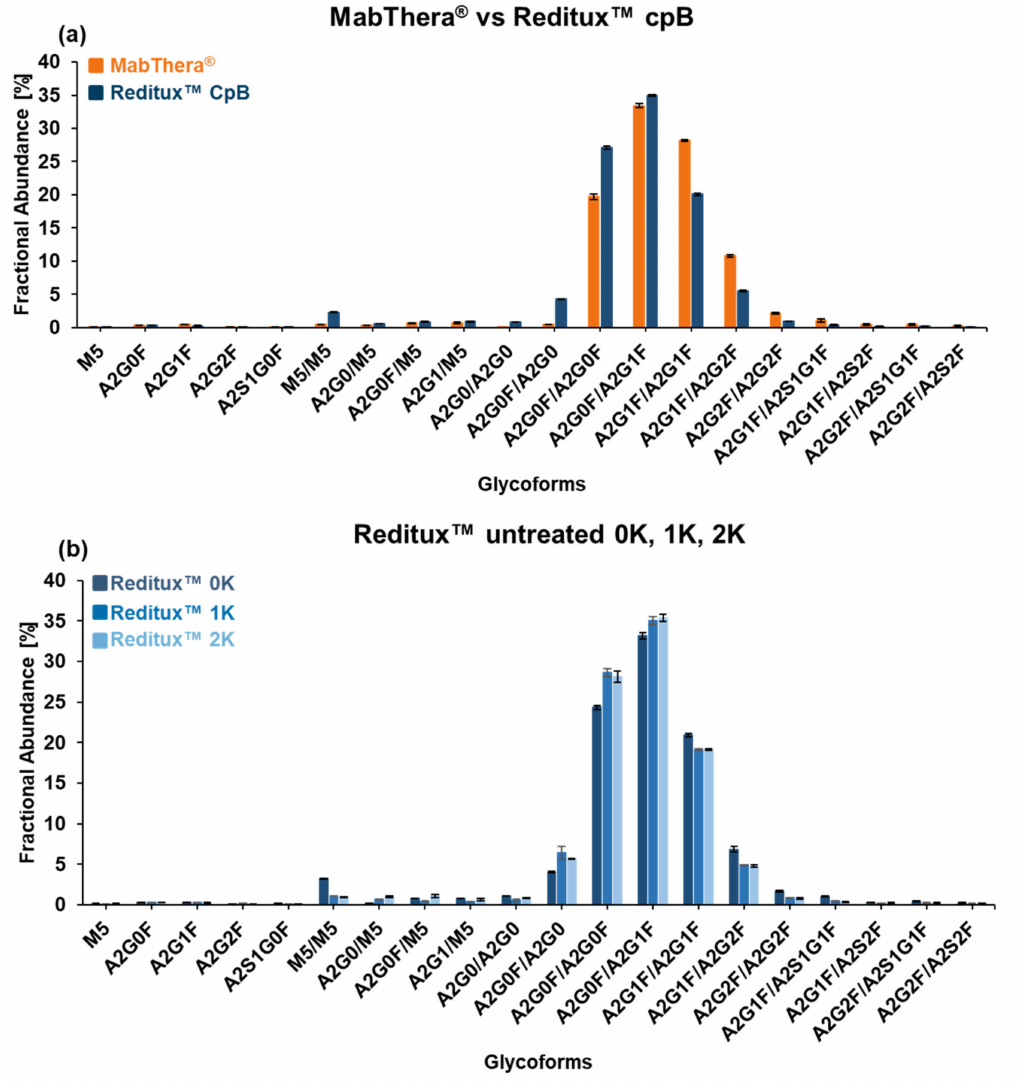
Figure 5. Glycoform fractional abundance was obtained by area integration of extracted ion current chromatograms (EICCs). Bar charts of glycoform fractional abundance of ( a ) MabThera ® and Reditux™ after carboxypeptidase B (CpB) tretament, ( b ) Reditux™ different lysine variants (0K, 1K, 2K). Columns represent averages and error bars, and the 95% confidence interval was calculated using a t-test from triplicate analysis. Glycoform name is reported in the x-axis. Table S7 reports the results in percentage. Glycan structures, names, and compositions are collected in Table